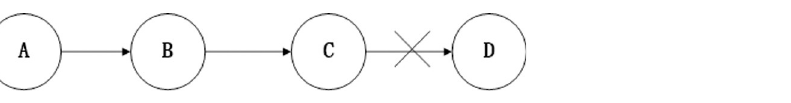
Fig 1. Routing maintenance example: Node C cannot forward the packet of node A to the next hop of the route.